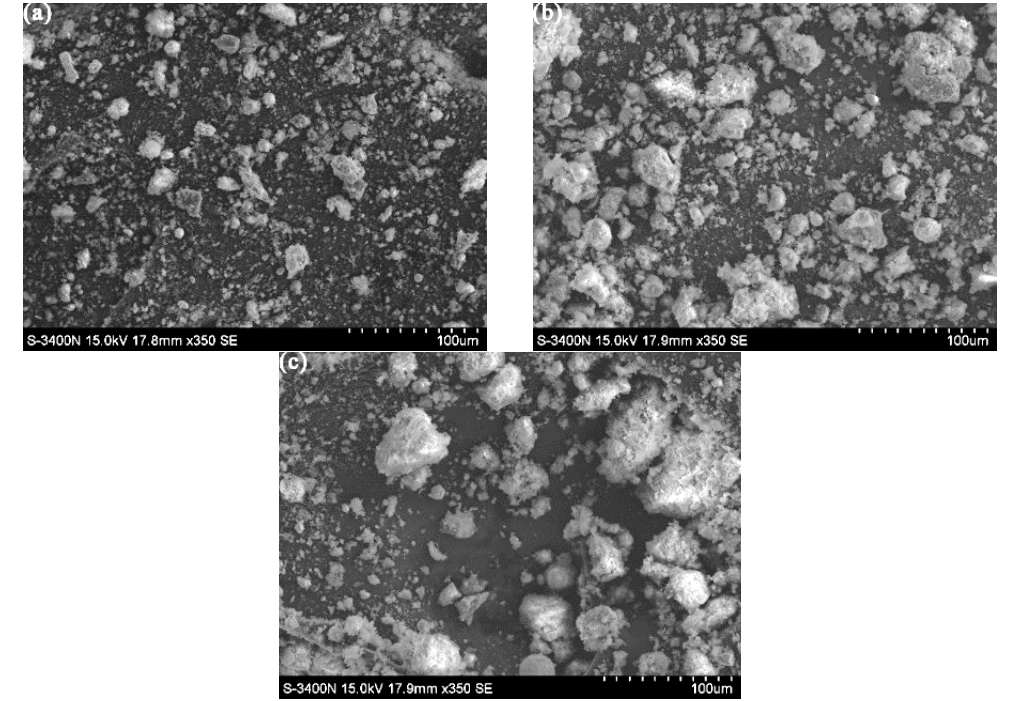
Figure 12: SEM photographs of machined debris: (a) Produced by non-abrasive round electrode; (b) Produced by abrasive round electrode; (c) Produced by abrasive shaped electrode.